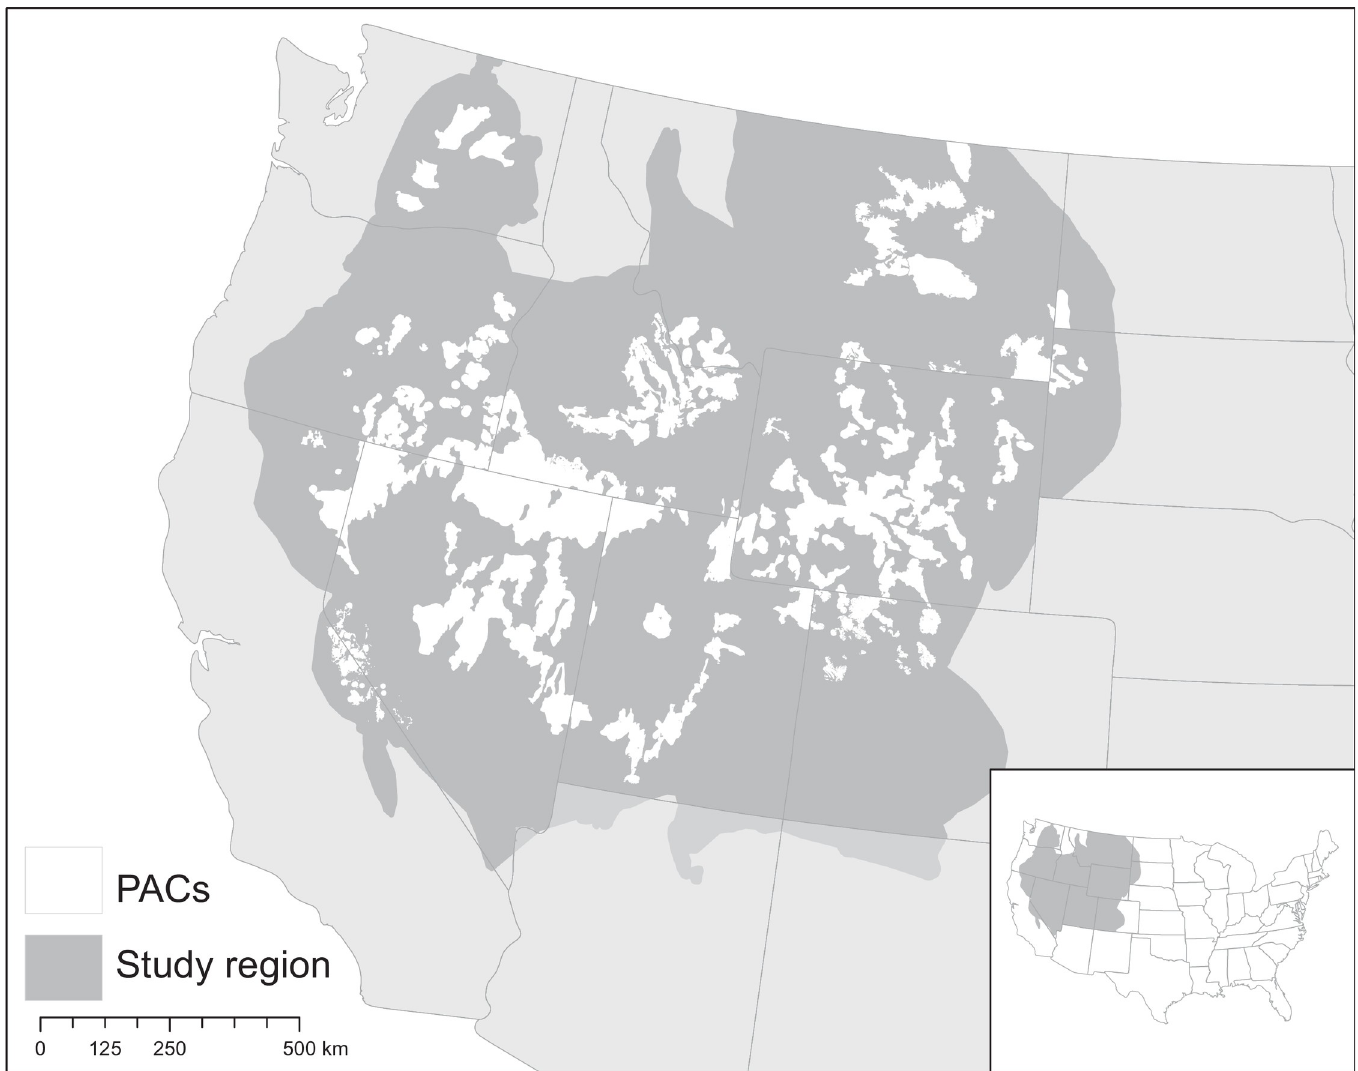
Fig 1. Map of the western US showing the boundaries of the sagebrush biome (study region) and Priority Areas for Sage Grouse Conservation (PACs), Albers equal area